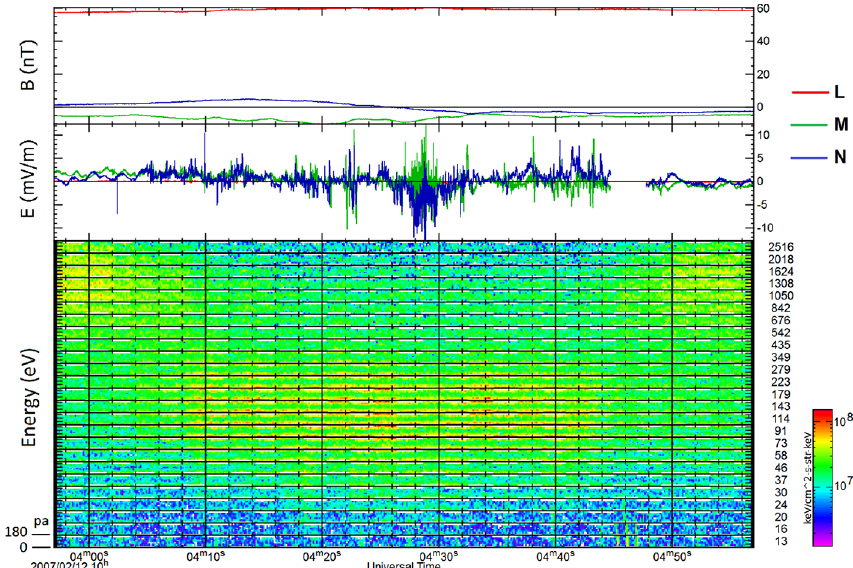
Figure 10. High-time-resolution observations by Cluster 3 from 10:03:57UT to 10:04:57UT: data are shown in the same format as in Fig. 5. Between 10:04:14 and 10:04:32UT, the B N component shows a bipolar signature, while for the electric field and electron pitch angle distribution, similar variations to those observed by Cluster 2 are evident. (See Fig. 9, and Sect. 4.4.3 for